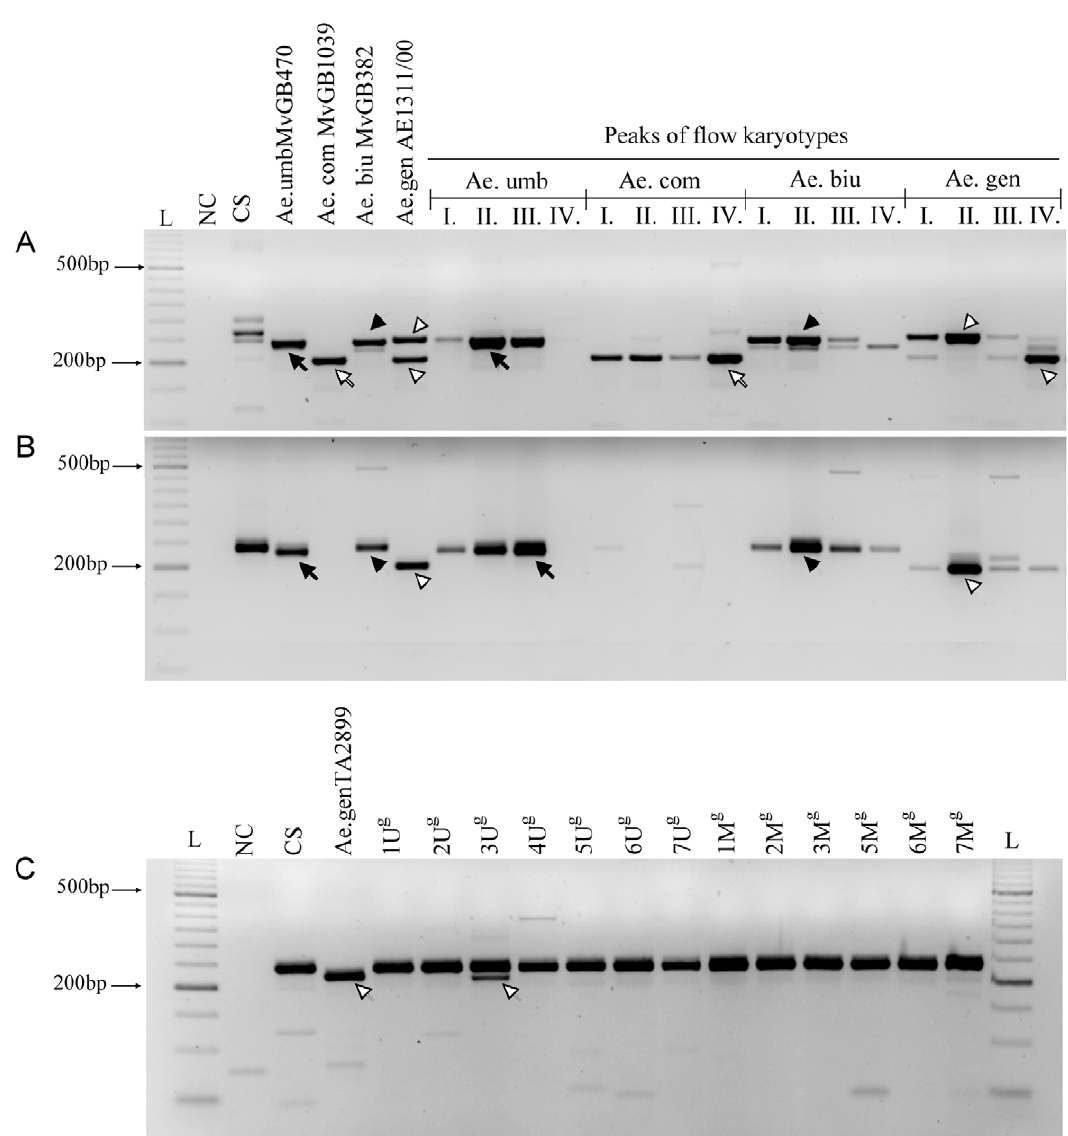
Figure 4. Physical mapping of microsatellite (SSR) markers. PCR products of wheat SSR markers Xcfa2040 (A); and Xcfa2134 (B–C) amplified from wheat cv. Chinese Spring, Ae. umbellulata MvGB470, Ae. comosa MvGB1039, Ae. biuncialis MvGB382 and Ae. geniculata AE1311/00 and from chromosomes of particular peaks of flow karyotypes (I, II, III, IV) (A–B); and from wheat- Ae. geniculata TA2899 addition lines (C). Black arrows, white arrows, black arrowheads and white arrowheads indicate bands specific for Ae. umbellulata , Ae. comosa , Ae. biuncialis and Ae. geniculata ,